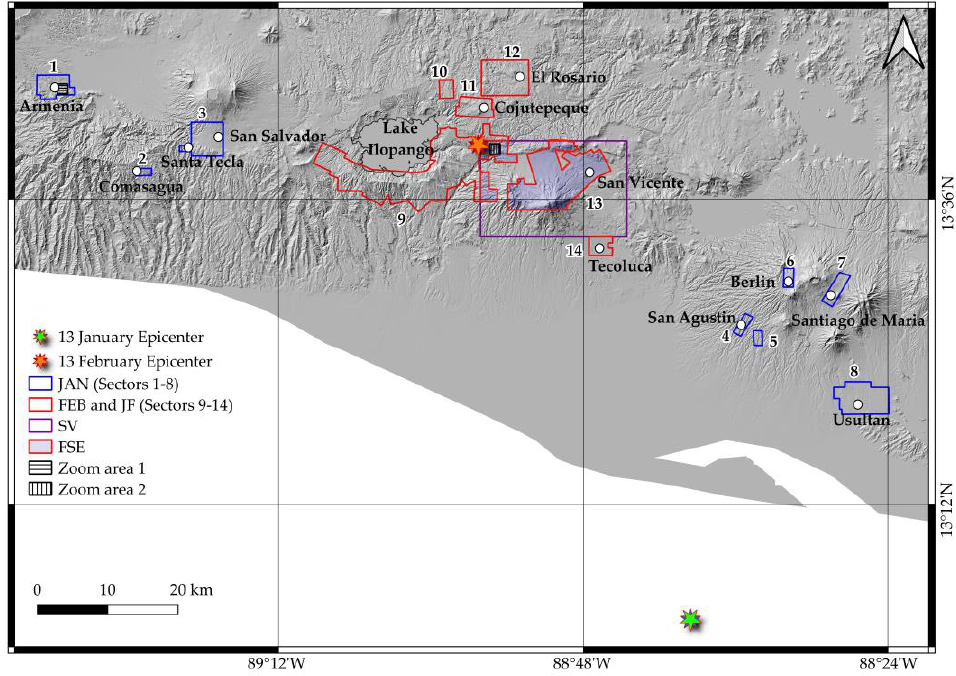
Figure 5. Locations of the datasets used for the landslide susceptibility modeling. Table 4. Datasets used to calibrate and validate the landslide predictive